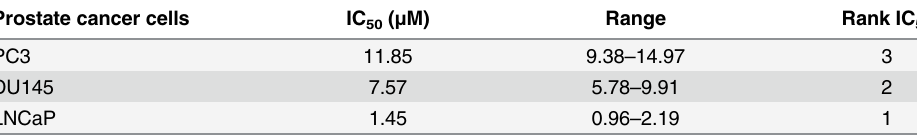
Table 1. IC 50 values of KML001 in prostate cancer